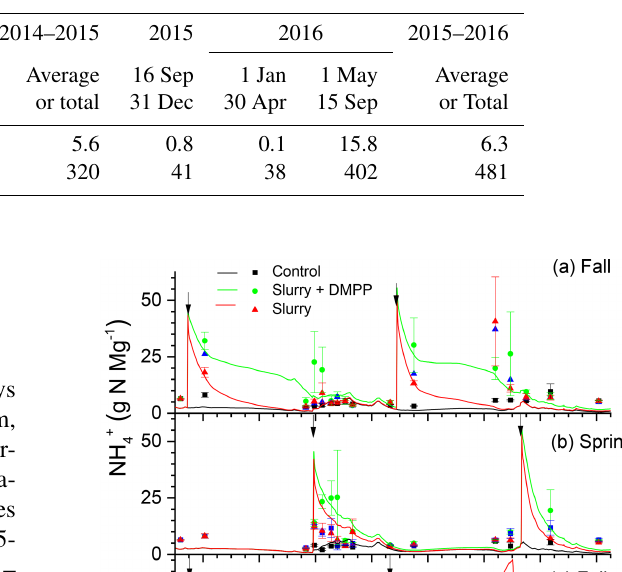
Table 4. Average temperatures and total precipitation measured at the Edmonton South Campus Farm during autumn–winter, winter–spring